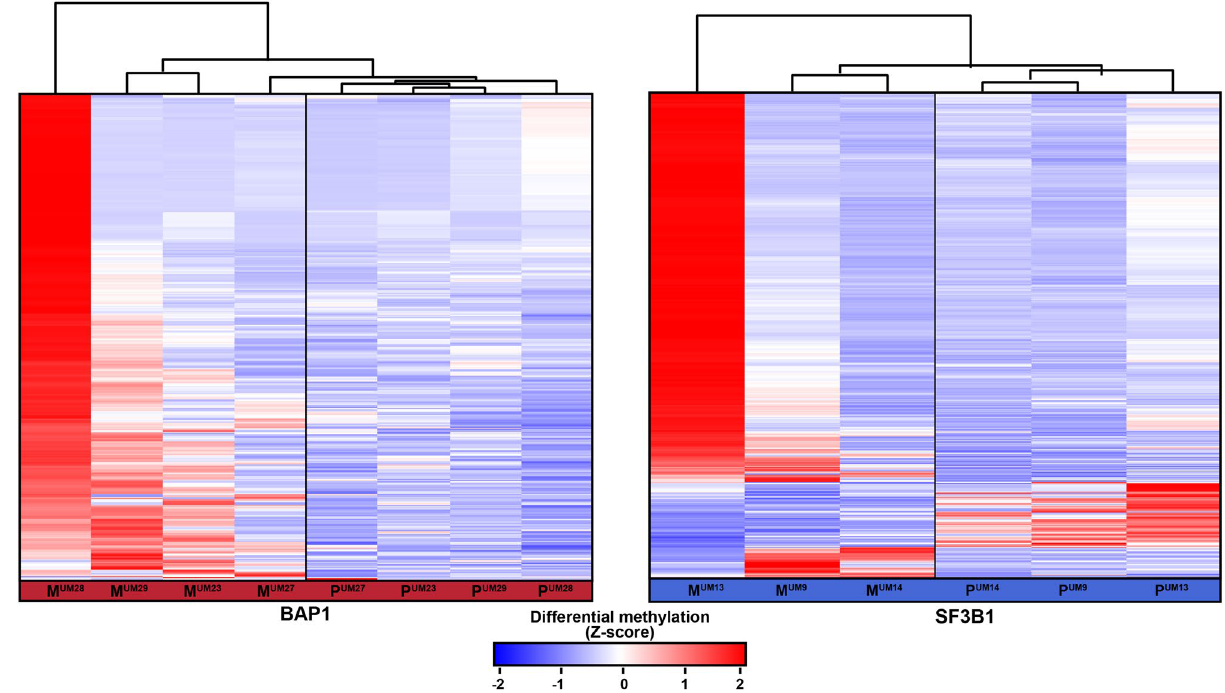
Figure 5. Heatmap visualizing the clustering of the 3 SF3B1 -mutated matched primary UM and UM metastases and 4 BAP1 -mutated matched primary UM and UM metastases based on DMR with a FC > 2. Red indicates hypermethylation, whereas blue indicated hypomethylation. Matched primary UM and metastases samples are marked by their sample number (UM23, UM27, UM28, UM29, UM9, UM13,